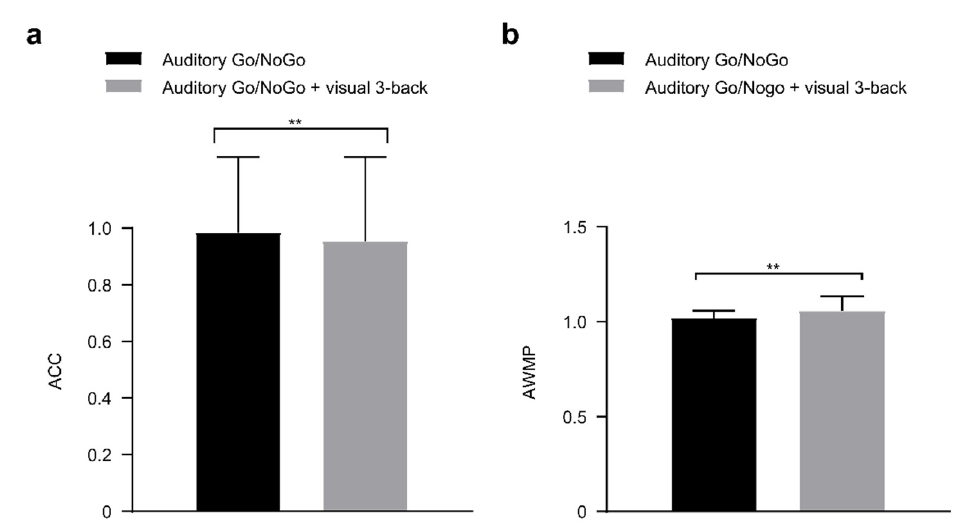
Figure 6. In visual 3-back interference conditions, ( a ) single-task (auditory) and dual-task (audiovisual interaction) groups for accuracy (ACC); ( b ) single-task (auditory) and dual-task (audiovisual interaction) groups for performance data (auditory working memory performance, AWMP). Between the single auditory Go/NoGo task and the dual auditory Go/NoGo + visual n-back task groups revealed significant differences, p < 0.01. All the data are presented as the mean ± S.D ( n = 44); ** p <